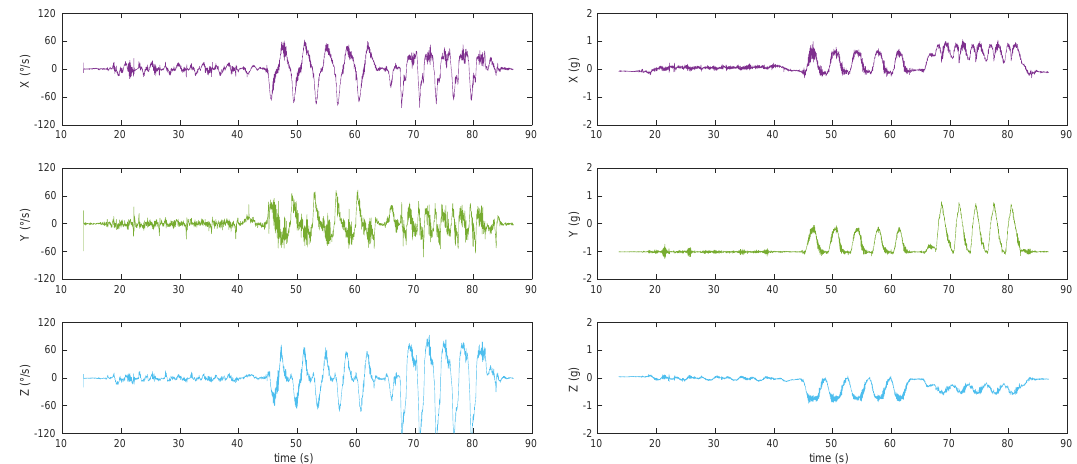
Figure 17. Signals recorded by the inertial platform during the exercises described in Figure 16. (Left panel) angular velocity as measured by the gyroscope. (Right panel) linear acceleration as measured by the inertial platform.